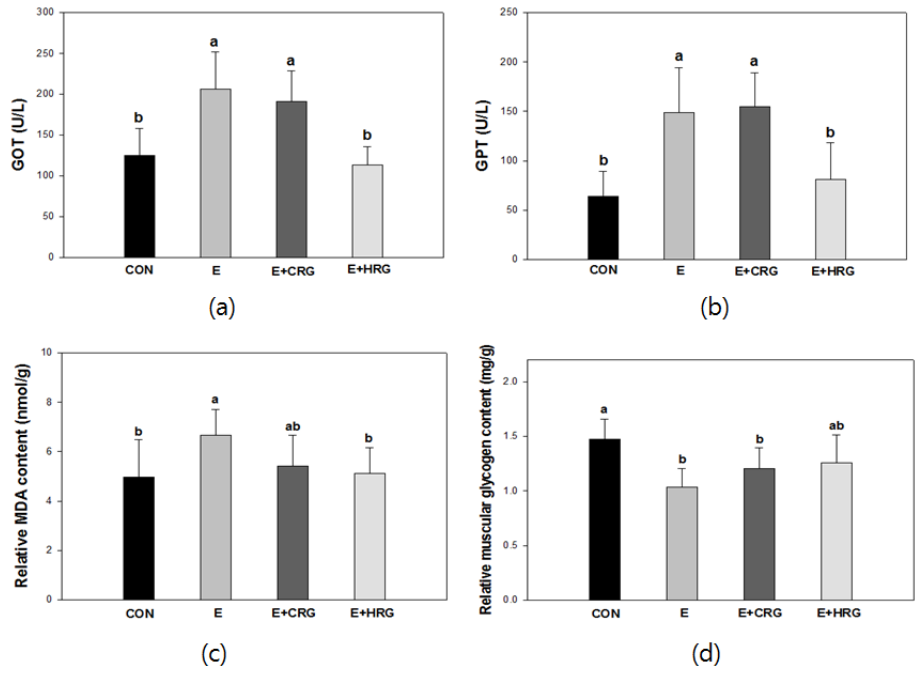
Figure 2. Effects of HRG on GOT ( a ), GPT ( b ), and MDA ( c ) levels and glycogen content ( d ) in blood and tissues. The results are given as the mean ± standard deviation ( n = 8).